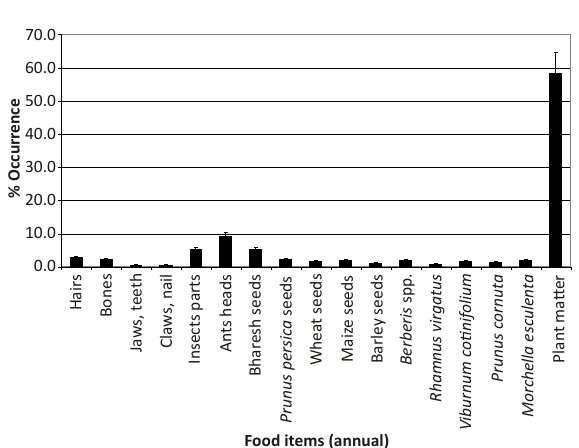
Figure 4. Frequency occurrence of food items in scats of the Himalayan Brown Bear in Kugti wildlife sanctuary during 2002–2004.